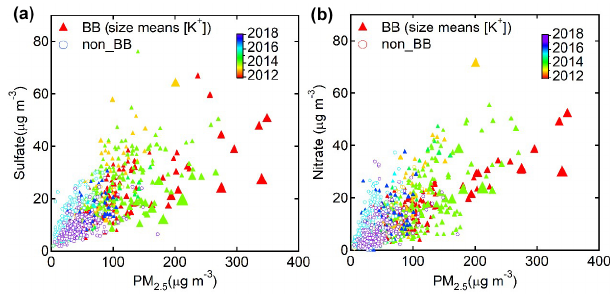
Figure 5. Scatter plots of (a) sulfate and (b) nitrate as a function of PM 2 . 5 for biomass burning (with K + higher than 75% percentile) and non-biomass burning (with K + lower than 25% percentile) cases for the period of 15 May–20 June during 2012–2018.